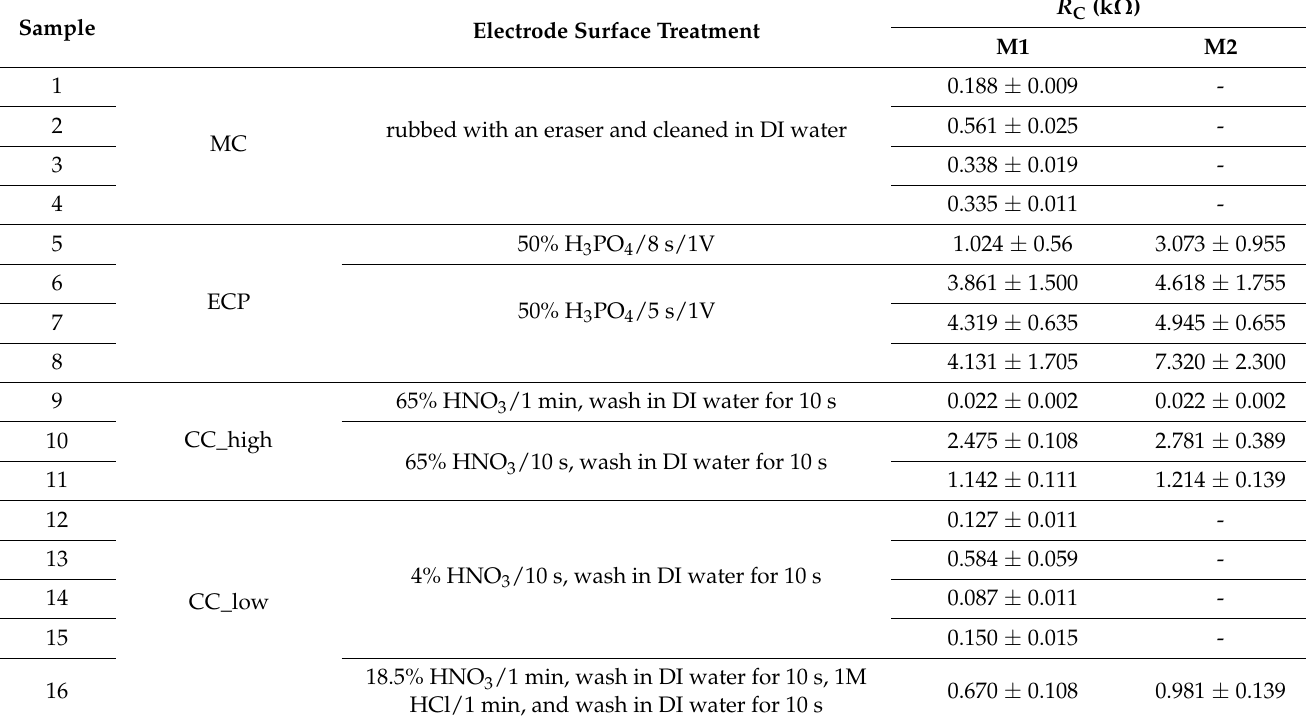
Table 1. Tested samples of 1L graphene on the Cu electrode system. M1 and M2 are the first, immediate measurement, and measurement after 14 days in an ambient environment,